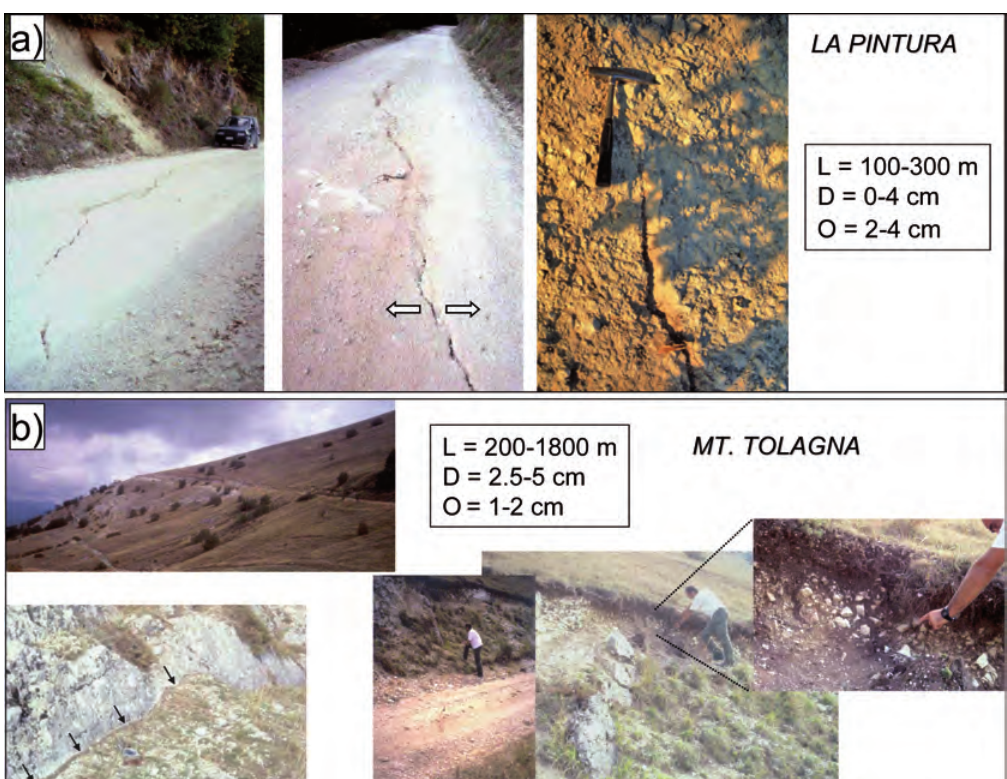
Fig. 6a,b. a) Discontinuous set of extensional fractures on a road at La Pintura site, which is coincident with a normal fault separating Mesozoic formation from late Quaternary deposits outcropping on the adjacent slope. Fractures generally have a right-stepping geometry: extension and small vertical offset occurs on the 135N to 145N-oriented segments, while NS-oriented segments appear closed, suggesting a left lateral component of mo- tion (photos from Cello et al ., 1998). To the right: fissure in Quaternary deposits formed adjacent to the pre-ex- isting fault plane (photo by P. Montone); b) View of the Mt. Tolagna fault scarp (upper left). To the right: frac- tured road and, according to Cello et al . (1998), reactivated bedrock fault plane showing a free-face (brown strip pointed by the arrows in photo to the lower left), and crack in hillslope deposits (person is pointing the feature). Photos courtesy of E. Tondi. Symbols: L = Length, D = Displacement; O =